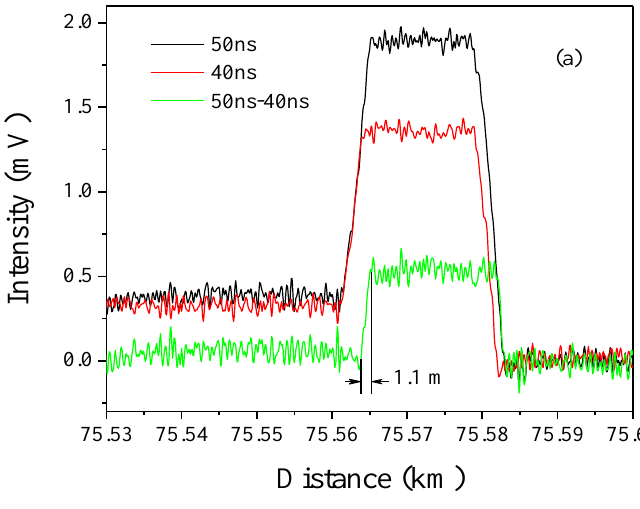
Figure 8. Time traces of the heated 18 m fiber using FDM-BOTDA with differential Brillouin gain technique. [26] (permitted by Nova Scientific